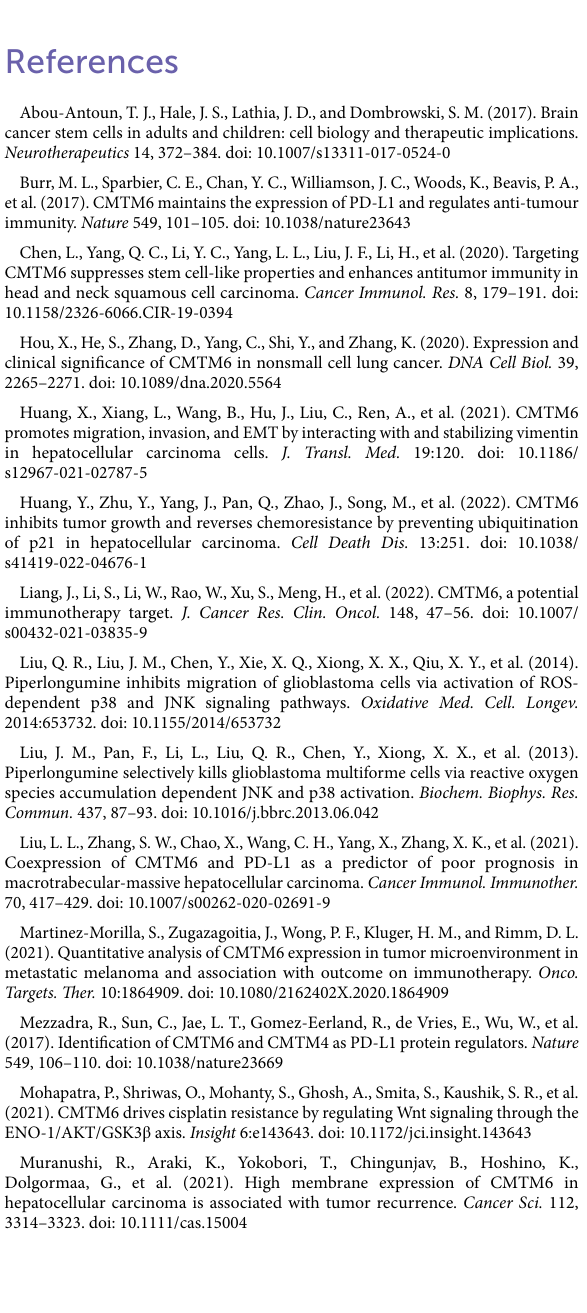
SUPPLEMENTARY FIGURE S2 The relationship between the expression of CMTM6 and the apoptosis and cellcycle of cells. (A) Flow cytometric apoptosis and result analysis of cells after up and down regulation of CMTM6. (B) Flow cellcycle and results analysis of cells after up and down regulation of CMTM6. * p <0.05. SUPPLEMENTARY FIGURE S3 The relationship between the expression of CMTM6 and the proliferation and invasion of cells. (A) Changes in cell proliferation ability at 24 h, 48 h and 72 h after up and down regulation of CMTM6. (B) Transwell invasion and result analysis of cells after up and down regulation of CMTM6. * p